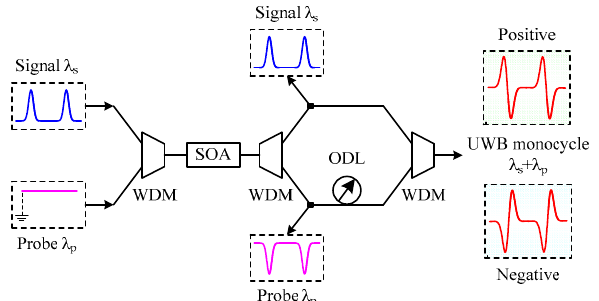
Fig. 1 Schematic illustration for the switchable and tunable UWB monocycle generator.